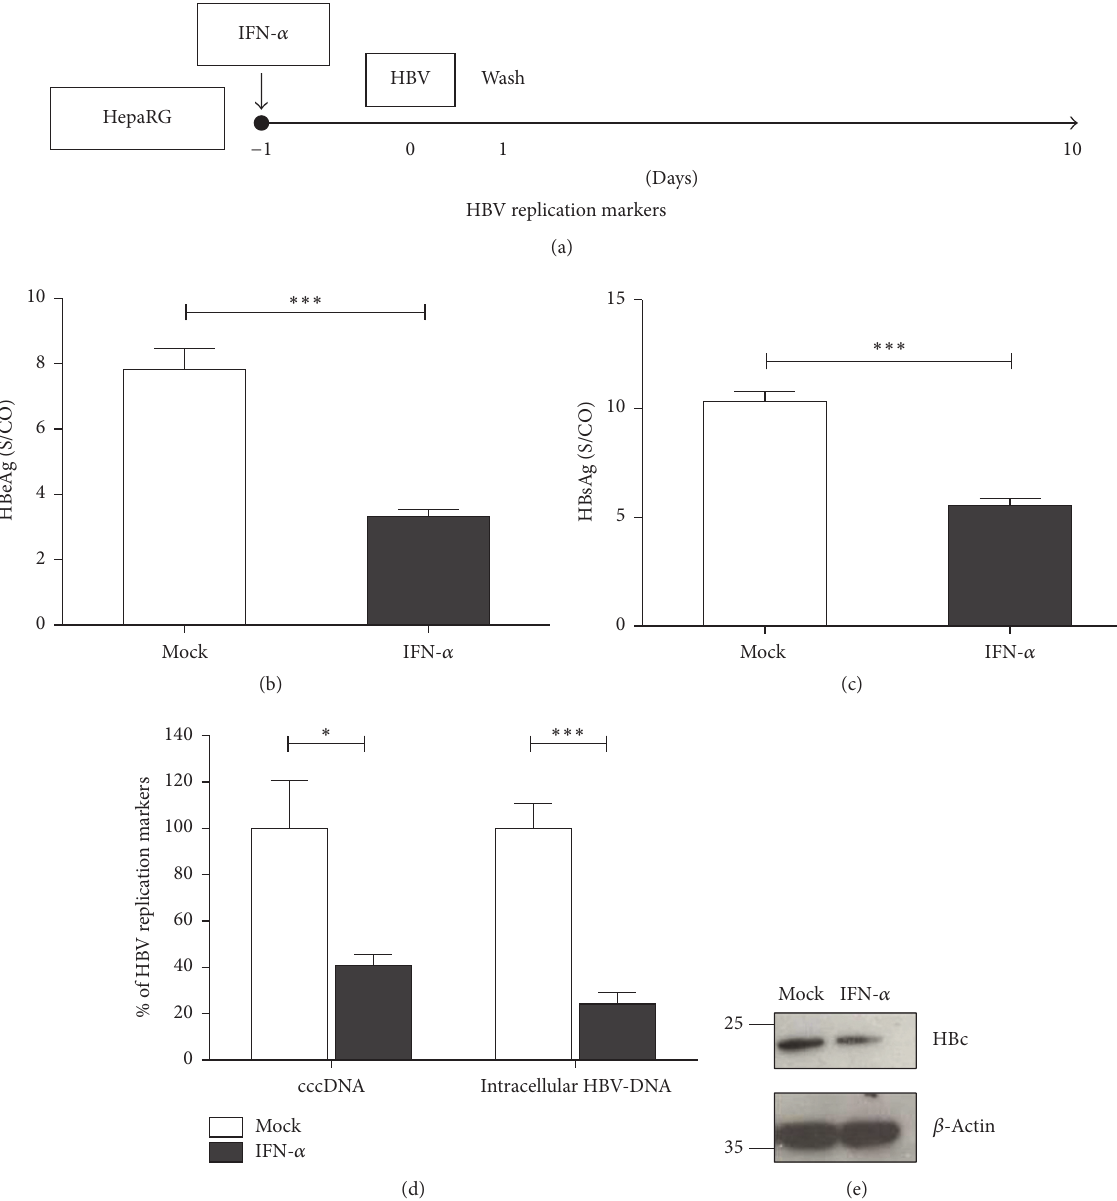
Figure 1: IFN- 𝛼 pretreatment inhibits HBV infection. Differentiated HepaRG cells were treated with 1000IU/mL of IFN- 𝛼 for 1 day (IFN- a( − 1)) and then infected with HBV (MOI = 200) (a). HBeAg from cell culture supernatant was measured by ELISA at day 10 (b). HBsAg was measured at day 7 and day 10 (c). HBV cccDNA and intracellular DNA were evaluated by qPCR (d). HBV core was detected by Western blot (e). Data are means ± s.d. ∗ 𝑃 < 0.05 , ∗∗ 𝑃 < 0.01 , and ∗∗∗ 𝑃 < 0.001 by Student’s unpaired two-tailed 𝑡